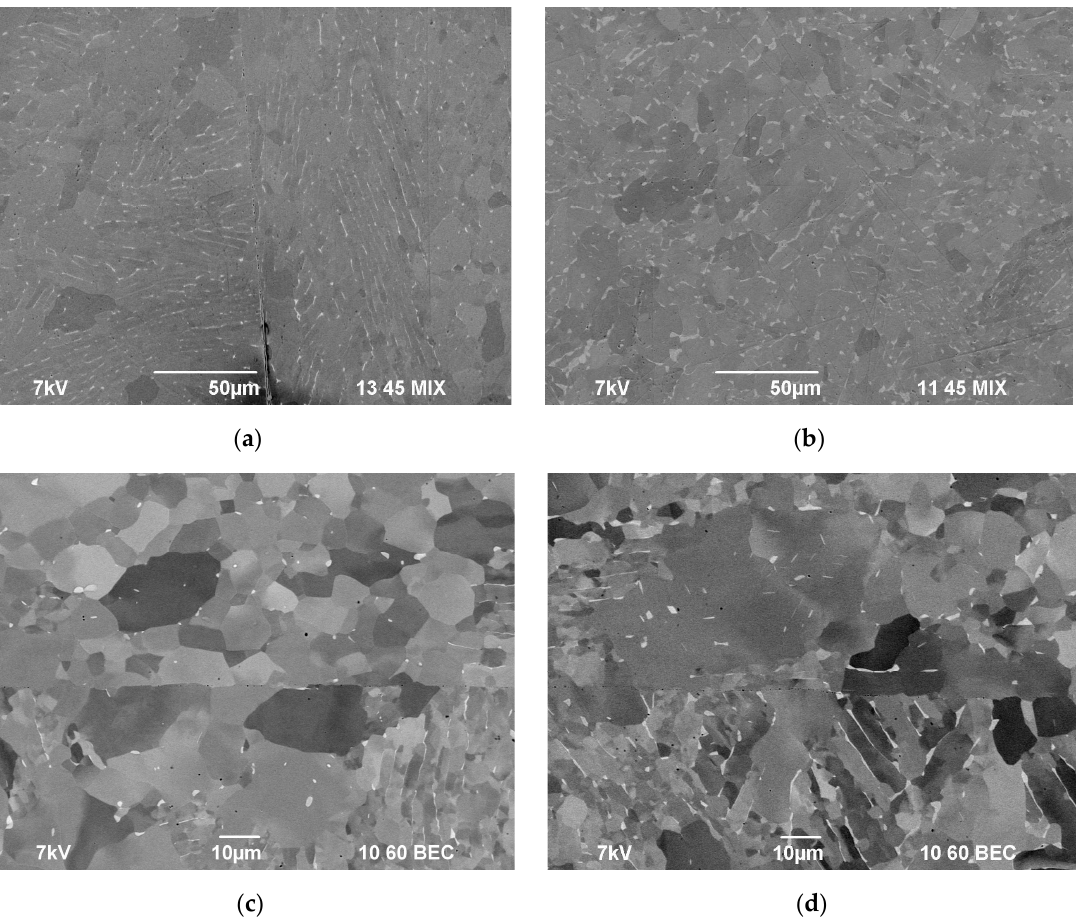
Figure 8. Microstructure of the specimens of the coarse-grained alloy obtained in di ff erent regimes of the di ff usion welding (P = 50 MPa, t = 10 min): ( a ) V h = 50 °C/min, T = 600 °C; ( b ) V h = 50 °C/min, T = 800 °C; ( c ) V h = 100 °C/min, T = 700 °C; ( d ) V h = 350 °C/min, T = 700 °C. SEM.